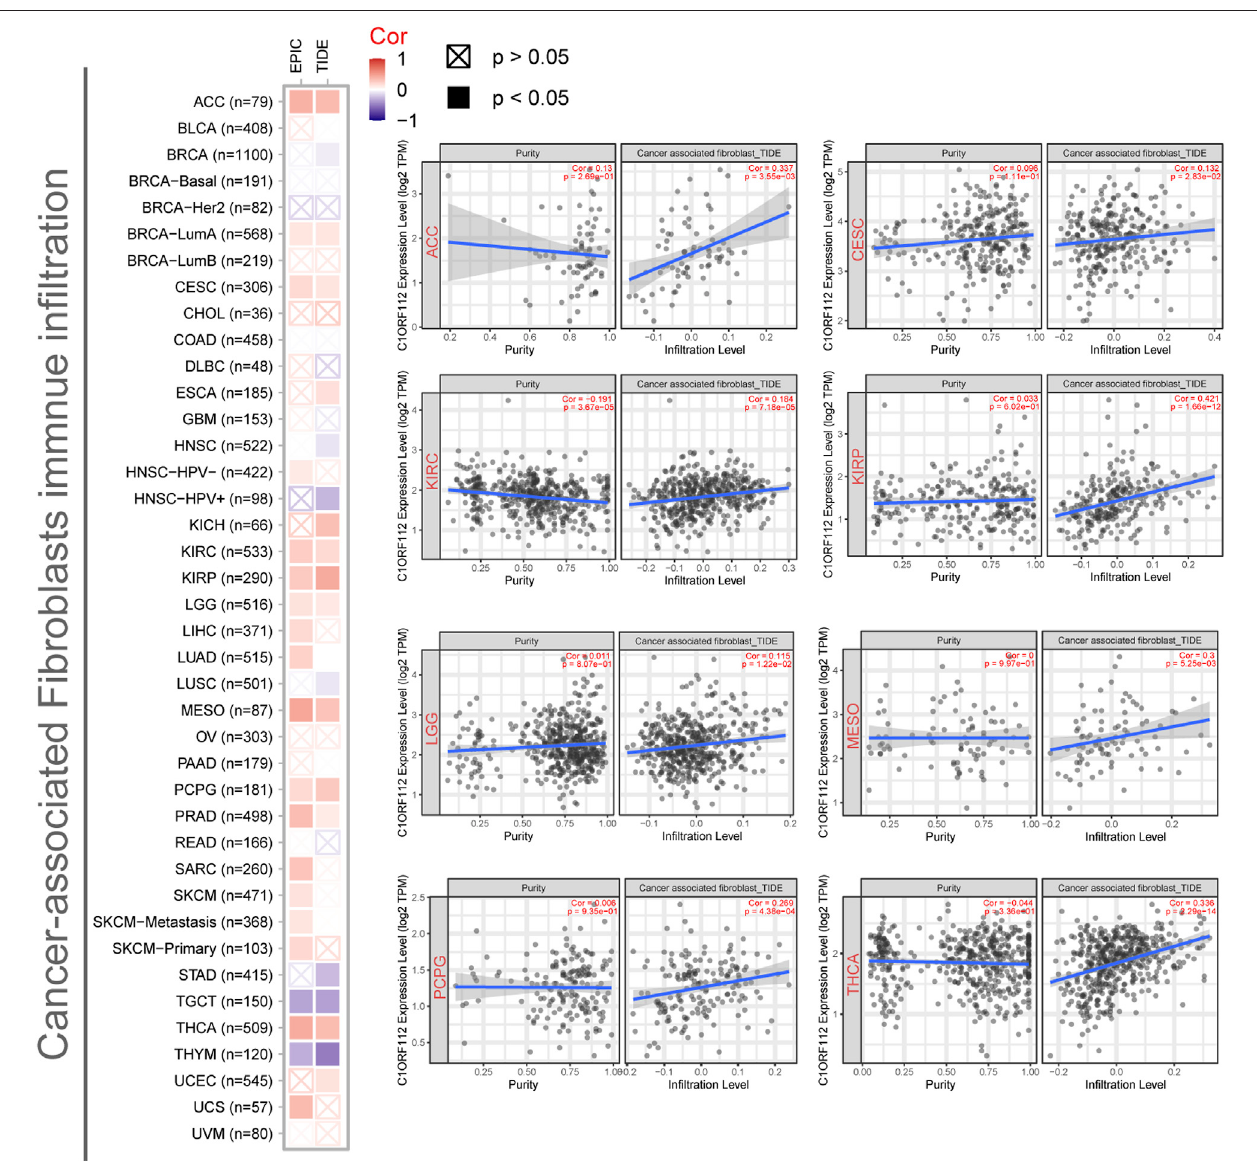
FIGURE5| Correlationbetween C1ORF112 expressionandcancer-associated fi broblastimmunein fi ltration.EPICandTIDEalgorithmswereusedtocalculatethe correlation between C1ORF112 expression and cancer-associated fi broblast immune in fi ltration in all tumor types from TCGA.